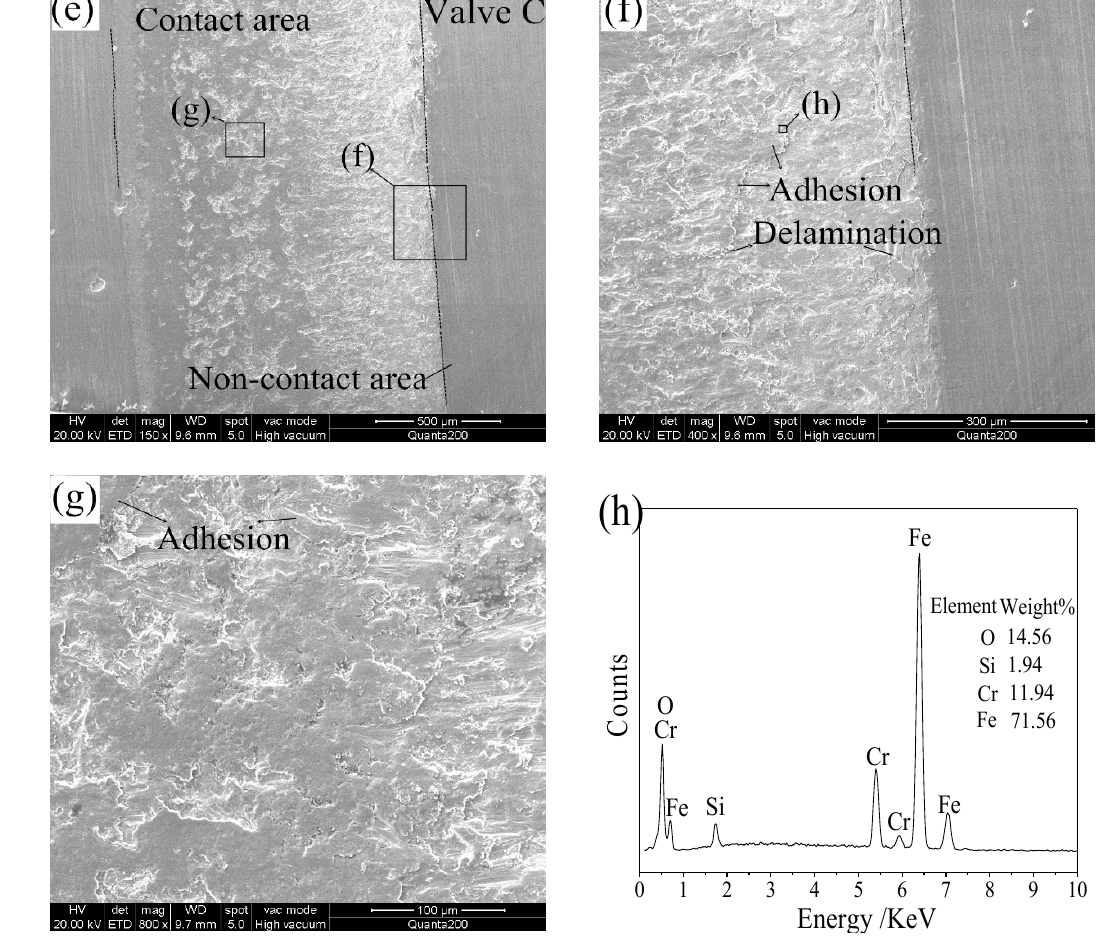
Figure 19. ( a ) Worn seating face of valve A; ( b ) near outer edge of seating face of valve A; ( c ) near inner edge of seating face of valve A; ( d ) enlarged view of adhesion on the worn seating face of valve A; ( e ) worn seating face of valve C; ( f ) near inner edge of seating face of valve C; ( g ) enlarged view of adhesion on the worn seating face of valve C; ( h ) EDS results of corresponding area of valve C.